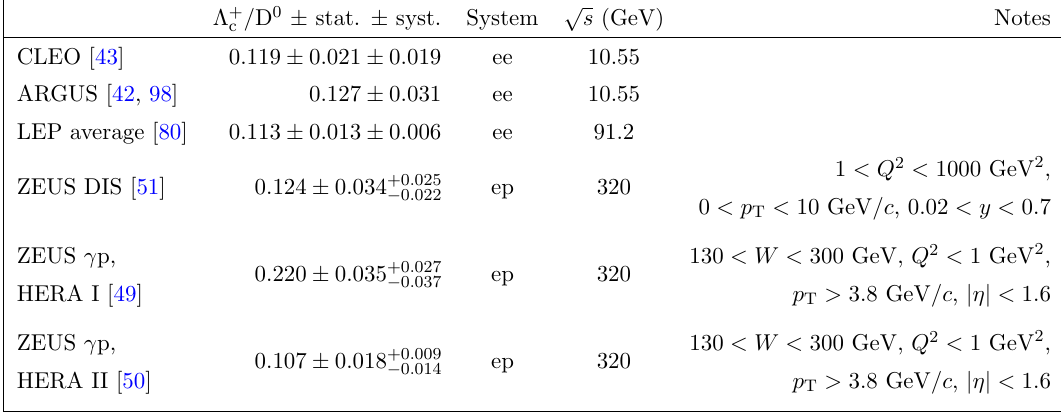
Table 5 . Comparison of the (cid:3) + /D 0 ratio as measured in e + e (cid:0) and ep collision systems and c at di(cid:11)erent centre-of-mass energies. Statistical and systematic uncertainties are reported (from references [42, 98] it was not possible to separate systematics and statistical uncertainties). See text for details about how the central values and quoted uncertainties were obtained. When indicated, the rapidity range refers to the centre-of-mass